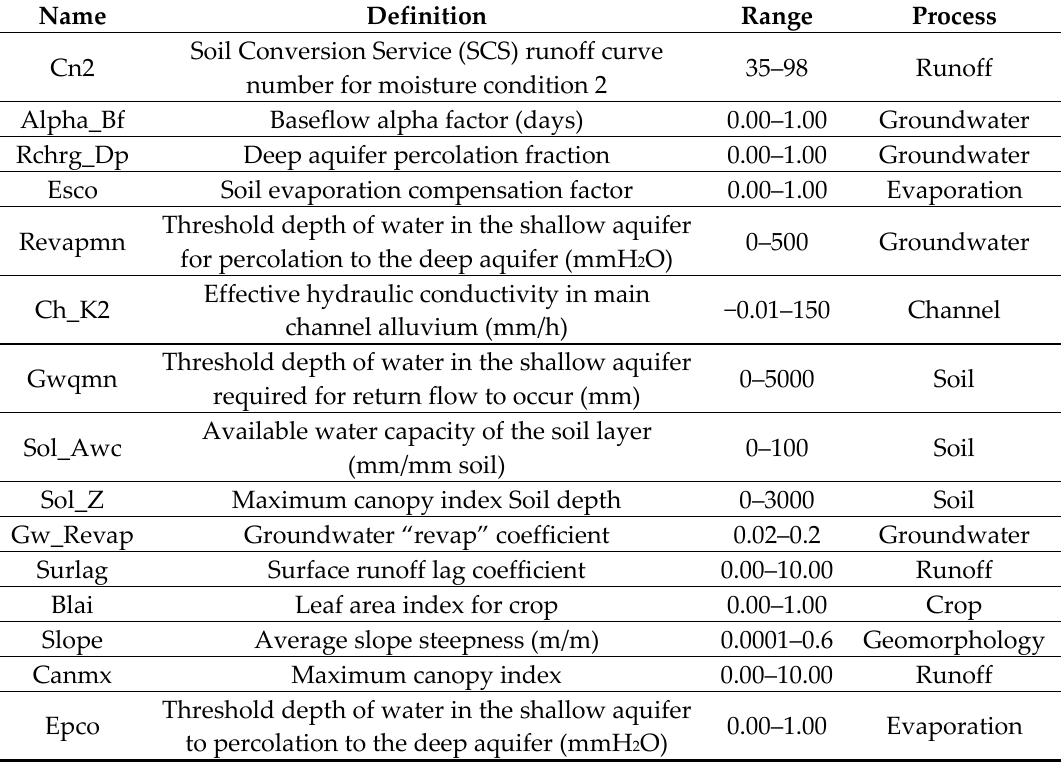
Table 2. Soil and water assessment tool (SWAT) model parameters used for the sensitivity analysis.